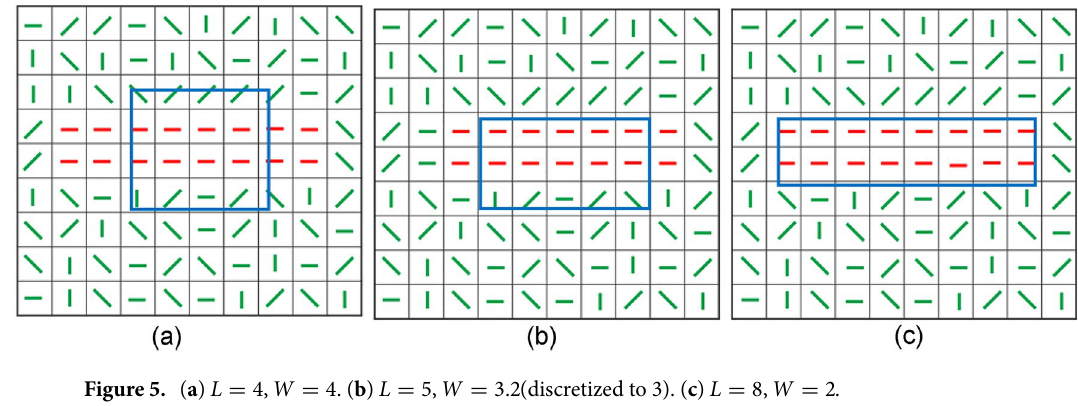
Figure 5. ( a ) L = 4, W = 4 . ( b ) L = 5, W = 3.2 (discretized to 3). ( c ) L = 8, W = 2 .